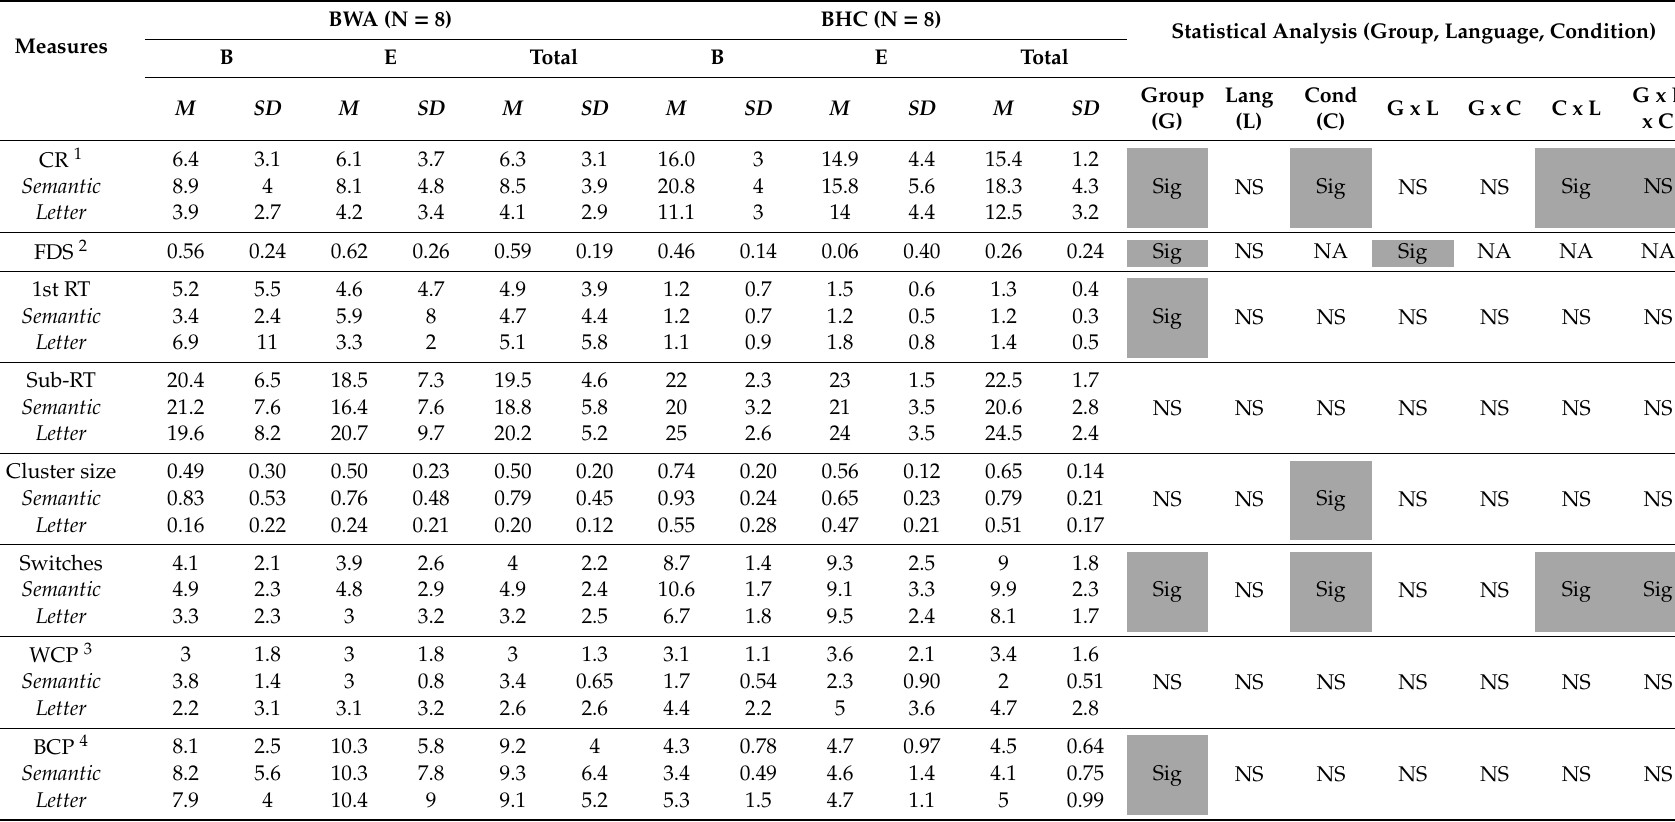
Table 6. Means, standard deviations, and the summary of statistical results of the dependent variables by Group, Conditions, and Language.